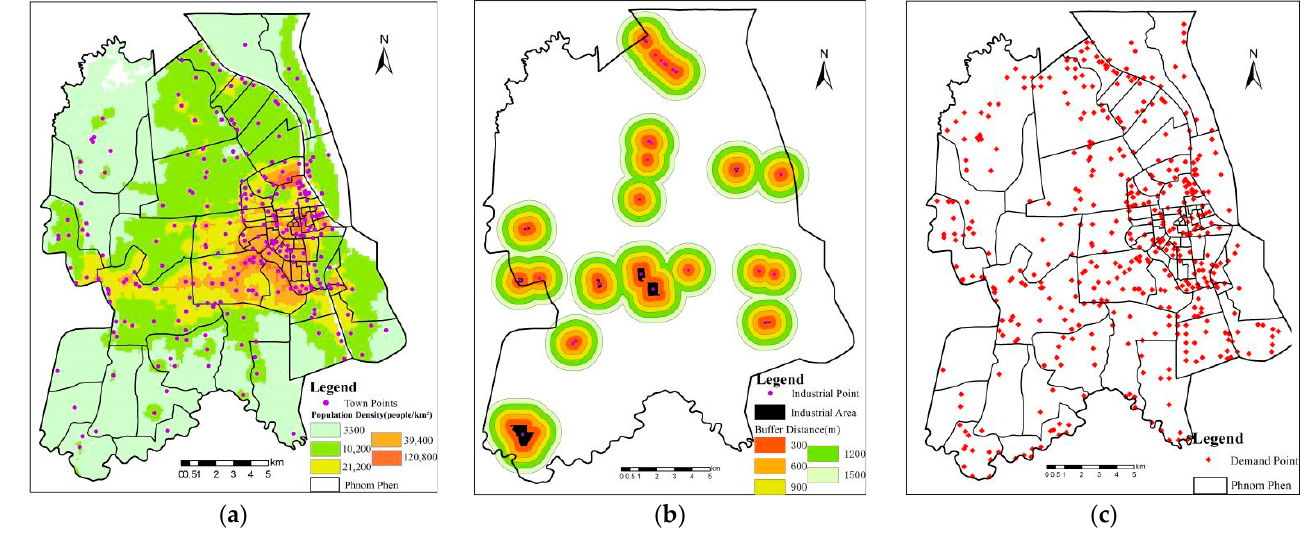
Figure 10. Demands distribution: ( a ) Population density map; ( b ) Industrial zone buffer map; ( c ) Total demand points.